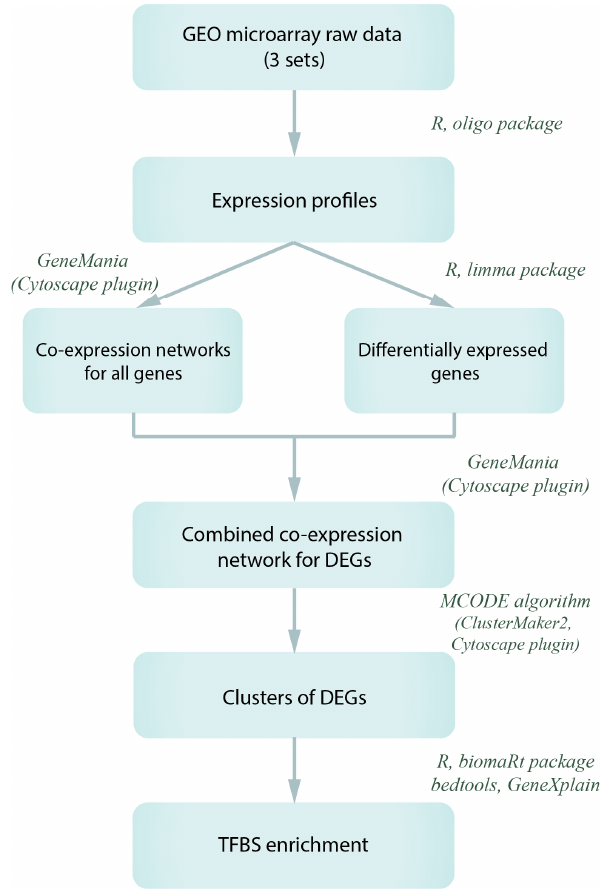
Figure 1. Workflow for the search and analysis of co-expression groups for the Gagr gene and genes with virus-induced expression. DEGs – differently expressed genes; TFBS – transcription factor binding sites.